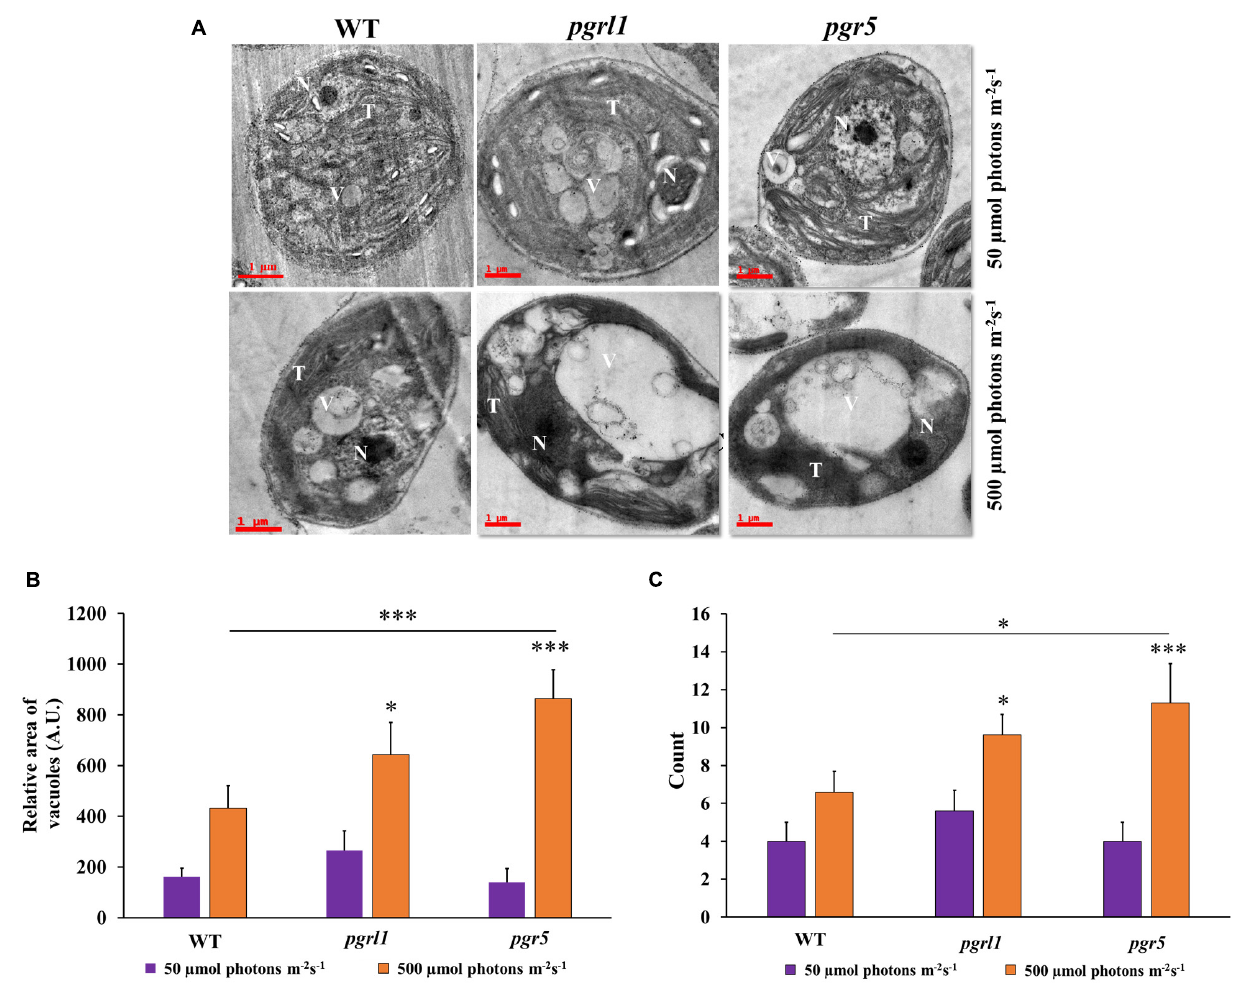
FIGURE 6 | Ultrastructure analysis of Chlamydomonas cells during normal (50 µ mol photons m − 2 s − 1 ) and high light (500 µ mol photons m − 2 s − 1 ). (A) Transmission electron micrographs of C. reinhardtii cells WT and mutants pgrl1 and pgr5 grown under photoheterotrophic conditions under normal (50 µ mol photons m − 2 s − 1 ) and high light (500 µ mol photons m − 2 s − 1 ). Representative images for the cells sampled after the 3rd day, N-nucleus; O, T-thylakoid membranes; V-vacuole. Three independent experiments were conducted from each sample ( n = 3). Scale bar = 1 µ m. (B) Quantification of area vacuoles. (C) The number of vacuoles. Quantification and number of vacuoles were performed from single cell with three independent cultures. Statistical significance was analyzed using one-way ANOVA with Tukey test and the p -value obtained are indicated ( ∗∗∗ p < 0.001, ∗ p <